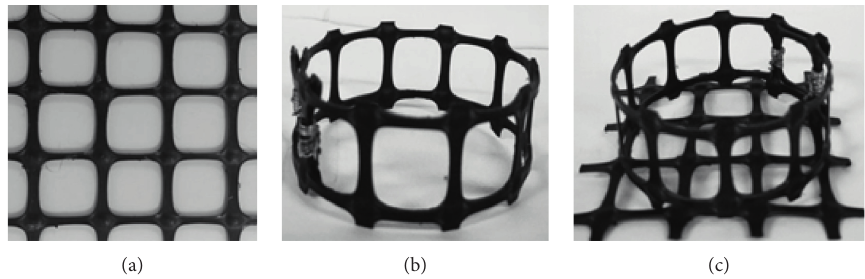
Figure 2: Different forms of reinforcement: (a) geogrid sheet, (b) Geogrid cell, and (c) combination.